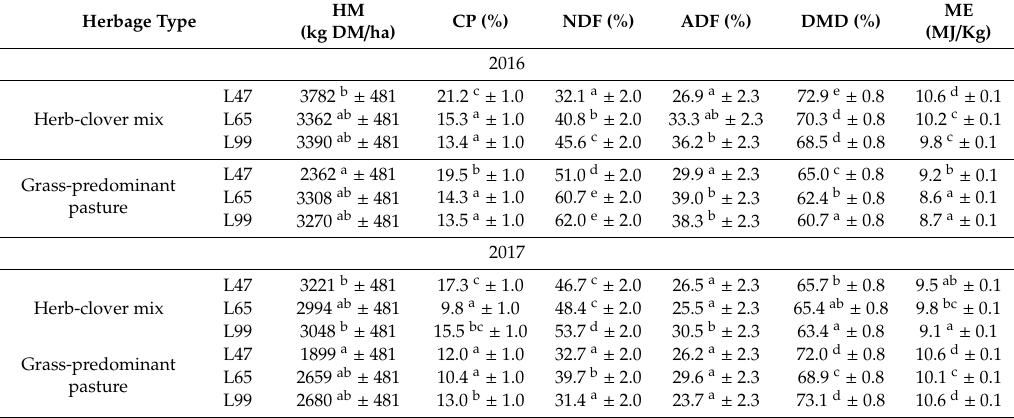
Table 1. Herbage mass (HM), crude protein (CP), neutral detergent fiber (NDF), acid detergent fiber (ADF), dry matter digestibility (DMD), and metabolizable energy content (ME) of herbage samples collected 47, 65 and 99 days after the midpoint of lambing in 2016 and 2017 (L47, L65 and L99) (least-squares mean ±